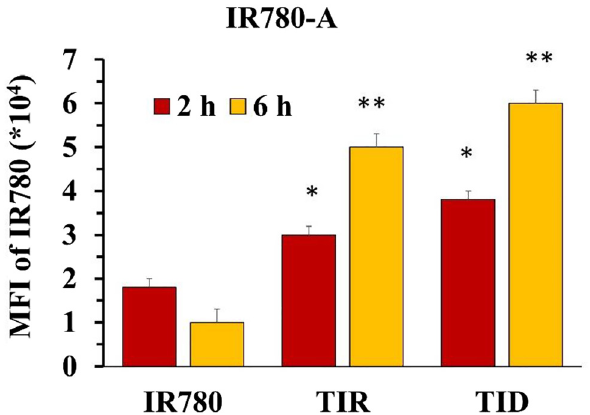
Figure 33: Quantitative analysis by flow cytometry of mean fluorescence intensity (MFI) of intracellular IR780 in 4T1 cells after 2- and 6-h incubation with free IR780, TIR, and TID NPs * P < 0.05 and ** P < 0.01 as compared to the control (785 nm, of 1.0 W cm − 2 , 5 min). Adapted from Wan et al.